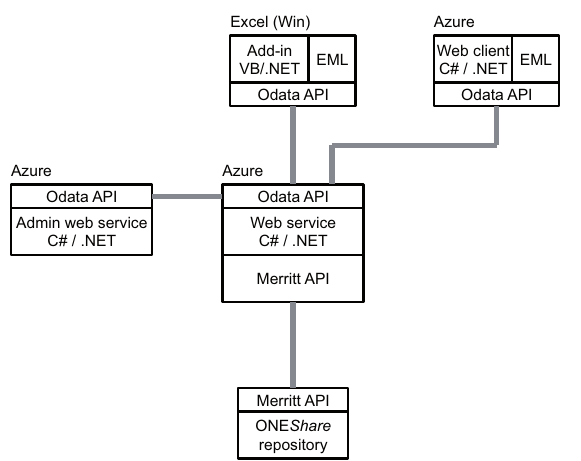
Figure 7. Architecture of the DataUp web service, web application, and add-in for Excel, and how they relate to the ONE Share